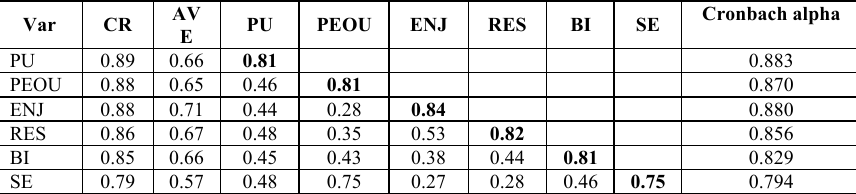
Table 2. Convergent and discriminant validity of model